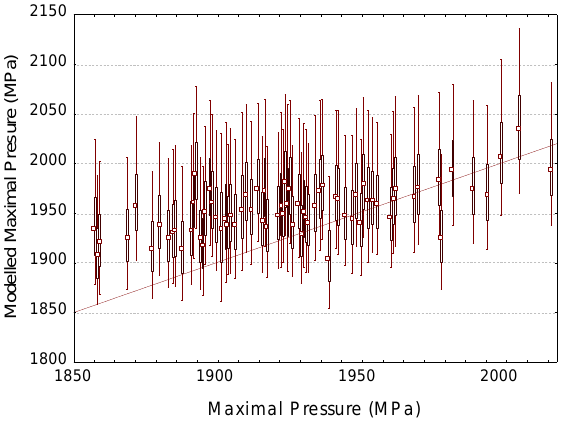
Figure 7. The 90% confidence intervals of modeled data by the Lambda distribution for the maximal pressure versus the pressure data values. The straight line represents y = x.